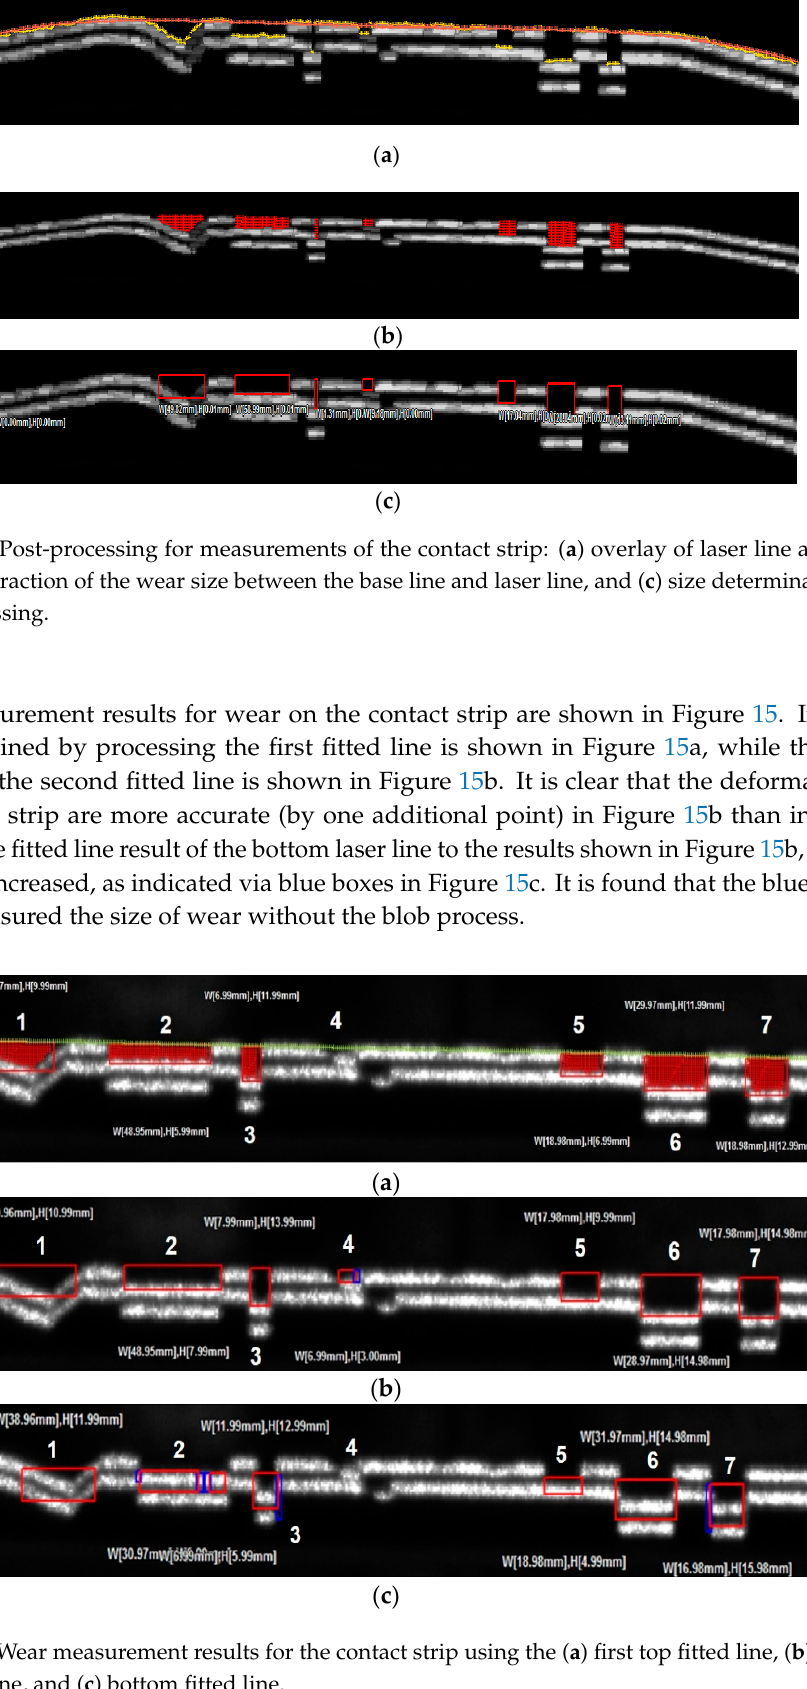
Figure 14. Post-processing for measurements of the contact strip: ( a ) overlay of laser line and base line, ( b ) extraction of the wear size between the base line and laser line, and ( c ) size determination via blob processing .